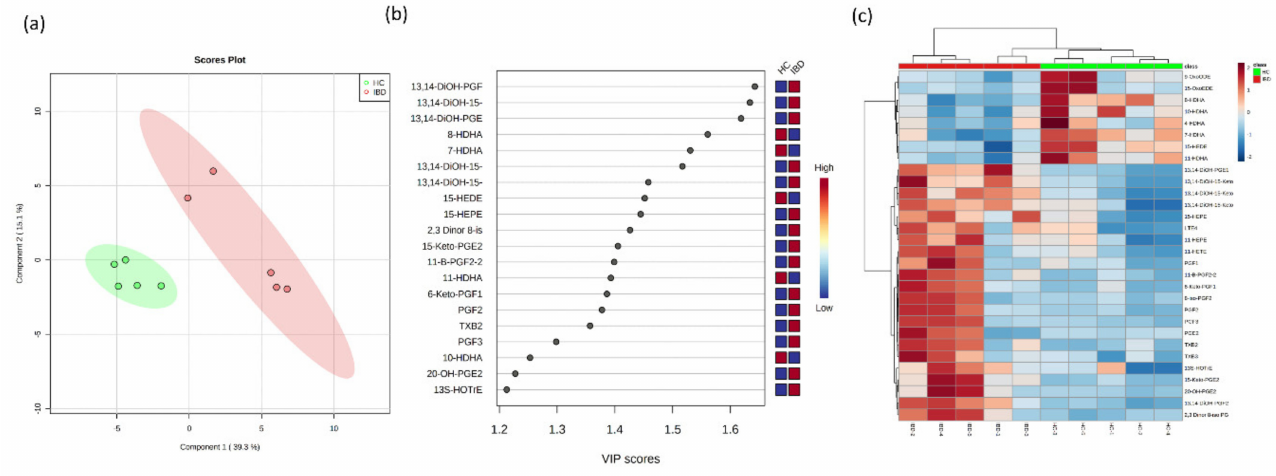
Figure 4. Multivariate Partial Least Squares-Discriminate Analysis (PLS-DA) analyses of the healthy control (HC) and inflammatory bowel disease (IBD) colon samples. ( a ) Two-dimensional PLS-DA score plot of the HC (green) and IBD (red) are separated from the other groups, indicating very distinct lipid metabolite compositions. Component 1 indicates the degree of variation between the groups based on their total metabolite contents, and component 2 indicates the differences within the groups. It can be noted that the component 1 value is three-fold greater than component 2, indicating that the differences between the groups are greater than within the groups. ( b ) Important features identified by the variable importance in the projections (VIP) scores; metabolites (20) with a VIP >1 have an above-average influence. ( c ) Hierarchical clustering analysis (heatmap) for the 30 most-altered metabolites. Each column in the heatmap represents a replicate, and each row represents a metabolite. The red and blue colors indicate the relative abundance intensity of each metabolite within a